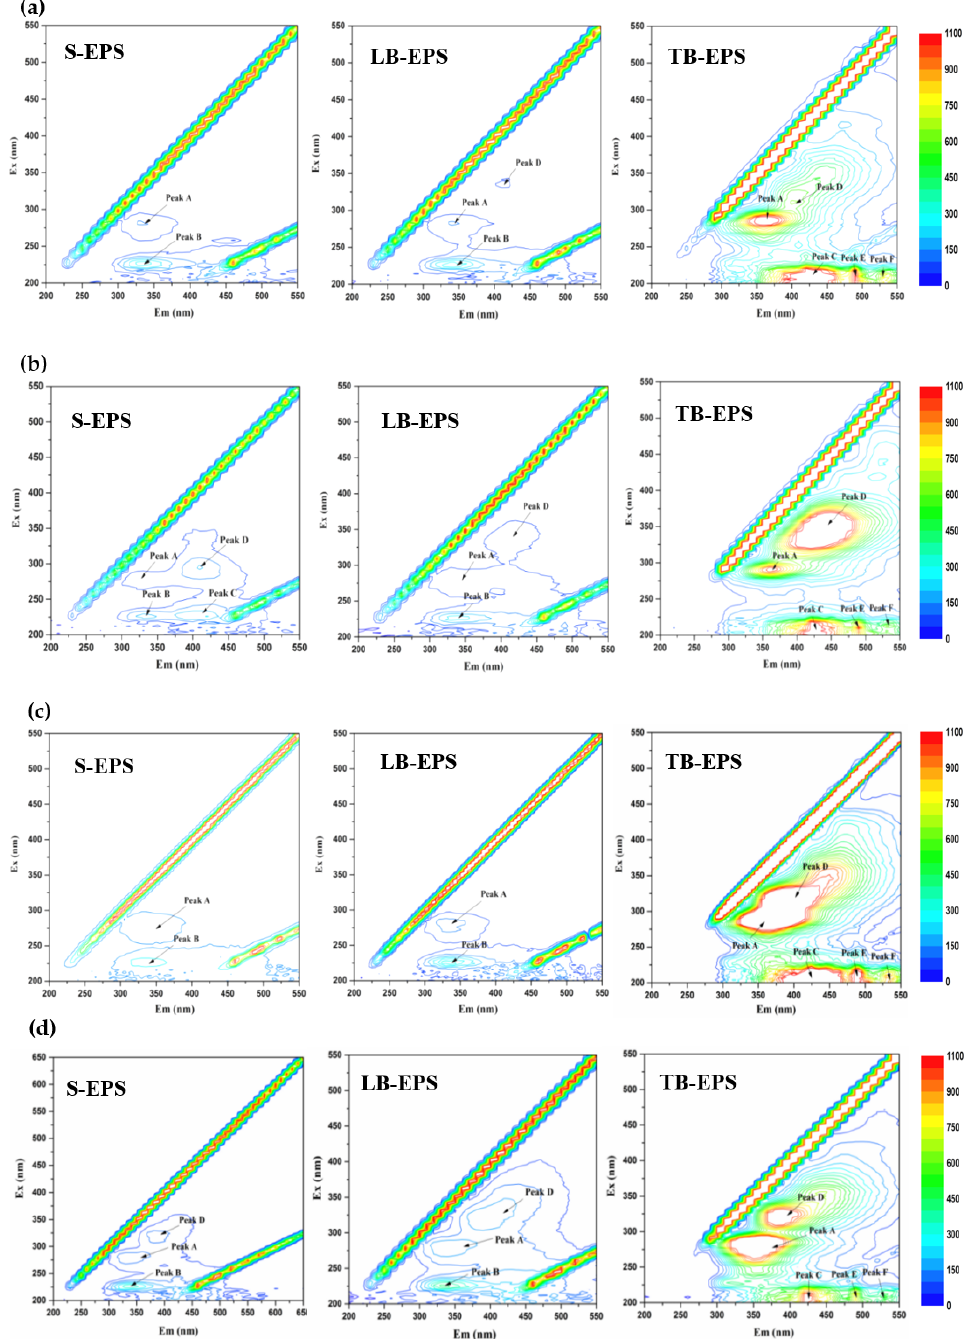
Figure 7. 3D ‐ EEM spectra of EPSs under four scenarios: ( a ) R1; ( b ) R2; ( c ) R3; ( d ) R4. Figure 7. 3D-EEM spectra of EPSs under four scenarios: ( a ) R1; ( b ) R2; ( c ) R3; ( d )